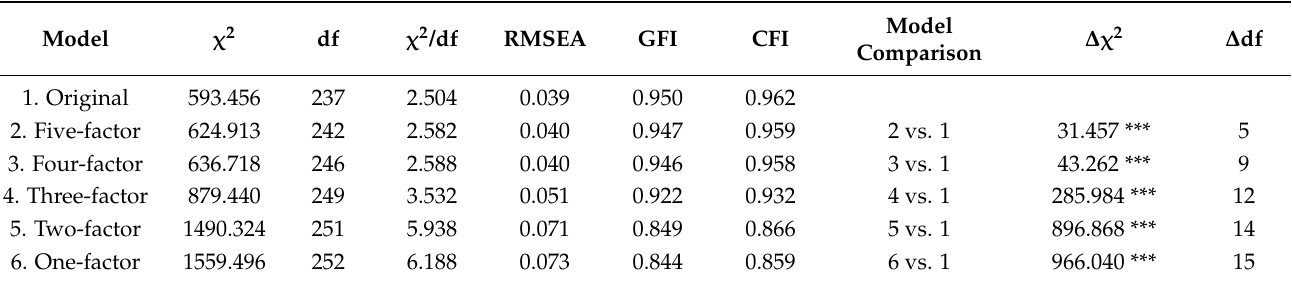
Table 4. Confirmatory factor analysis of discriminant